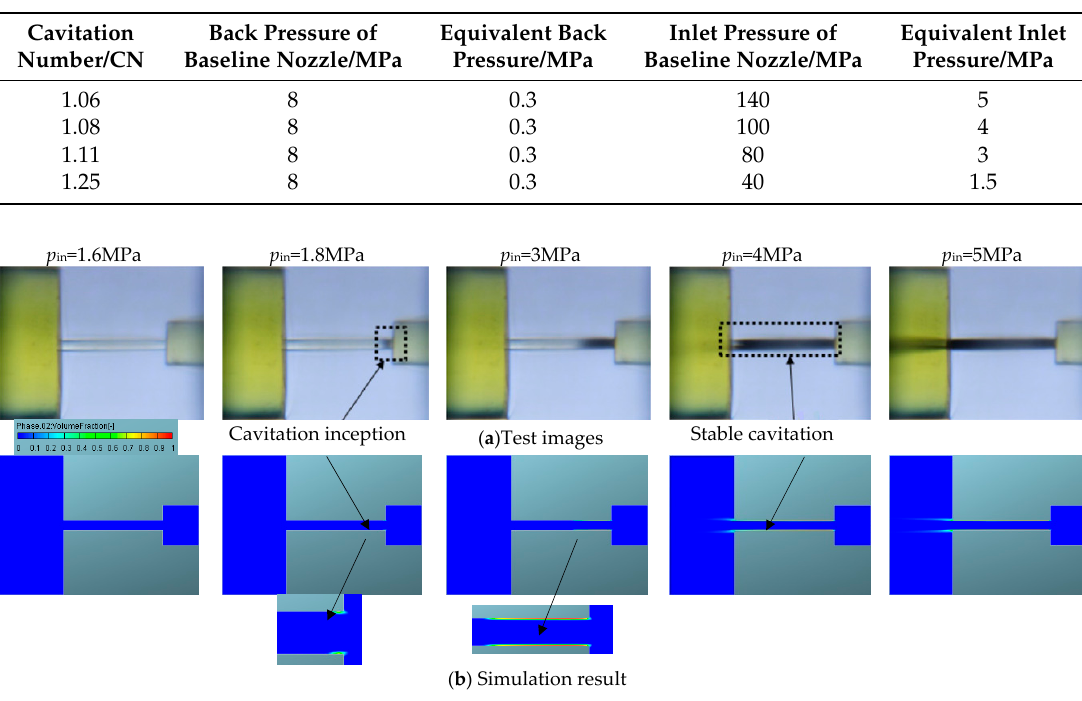
b = 0.3 MPa). Figure 4. Comparison of experimental and simulation results ( p b =0.3MPa).